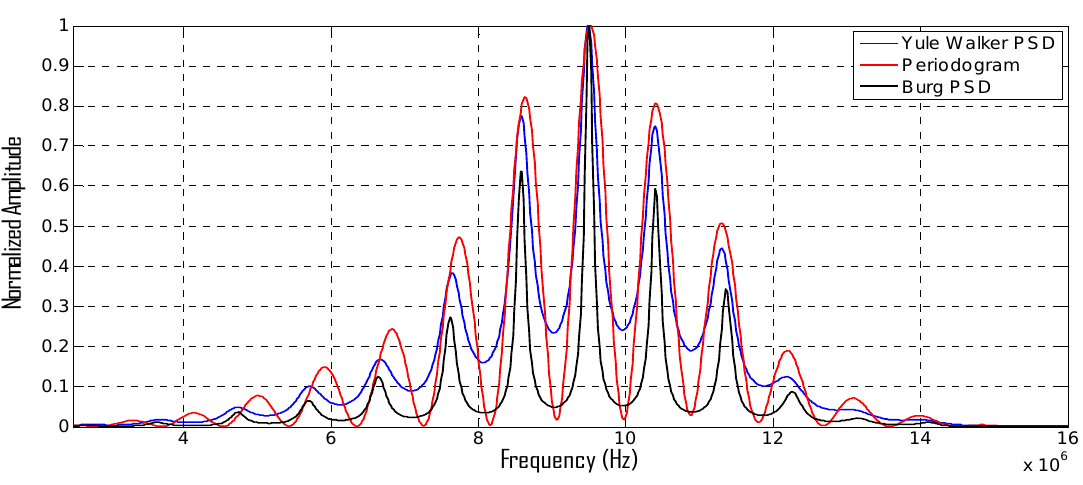
Figure 7. PSD estimations by applying a non parametric technique (Periodogram) and our two parametric options based on the Yule Walker and Burg methods.